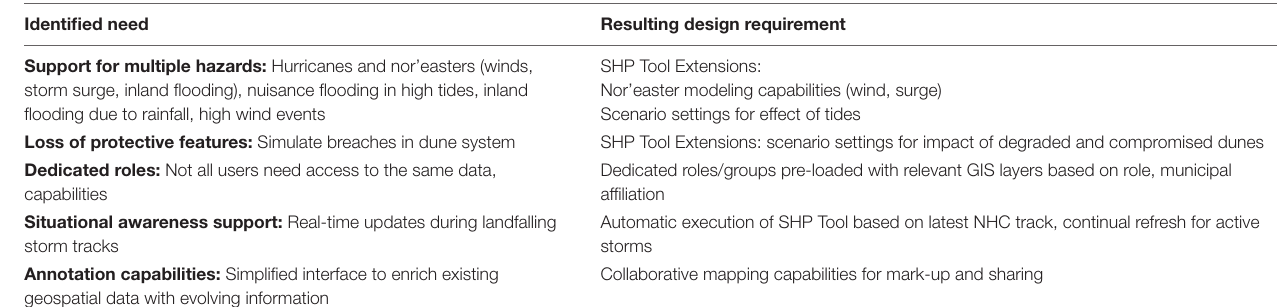
TABLE 1 | Identified user needs and design